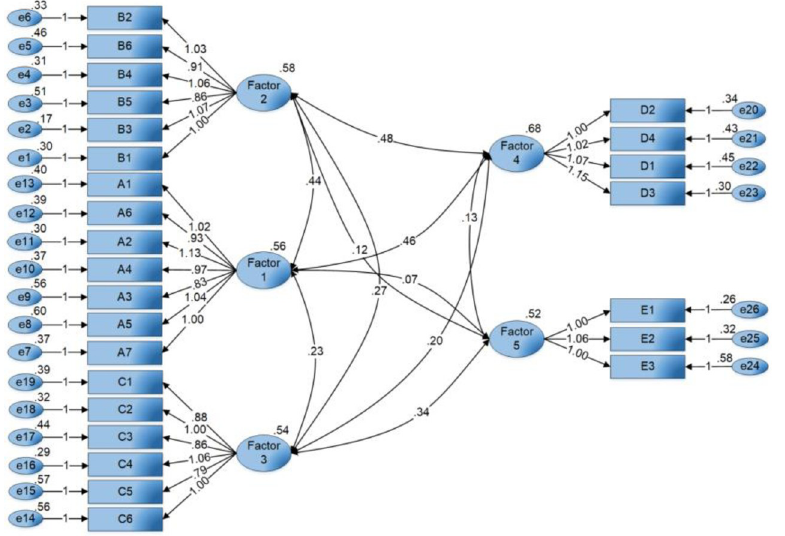
Fig 8. The verification measurement model.